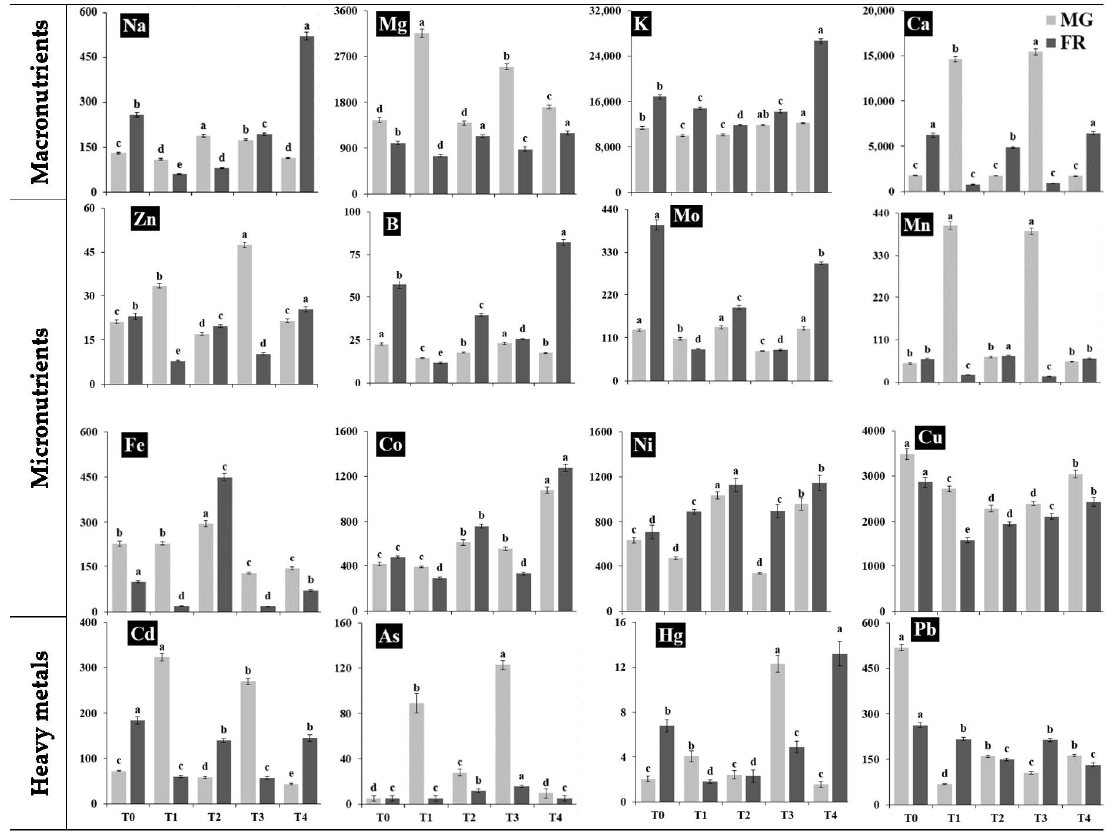
Figure 2. Level of mineral nutrients and heavy metals in loquat fruit’s peel as affected by the exogenous application of Mg, Zn, and B. Different letters indicate a significant difference among treatments for each series according to Fisher’s least significant difference test at α = 0.05. Vertical bars indicate average ± standard error (four replicates, p ≤ 0.05). T 0 —control; T 1 —2% MgSO 4 .7H 2 O, T 2 —0.1% ZnSO 4 .7H 2 O, T 3 —0.2% Na 2 B 4 O 7 .10H 2 O and T 4 —T 1 +T 2 +T 3 (1:1:1), MG—mature green stage, FR—fully ripe stage.